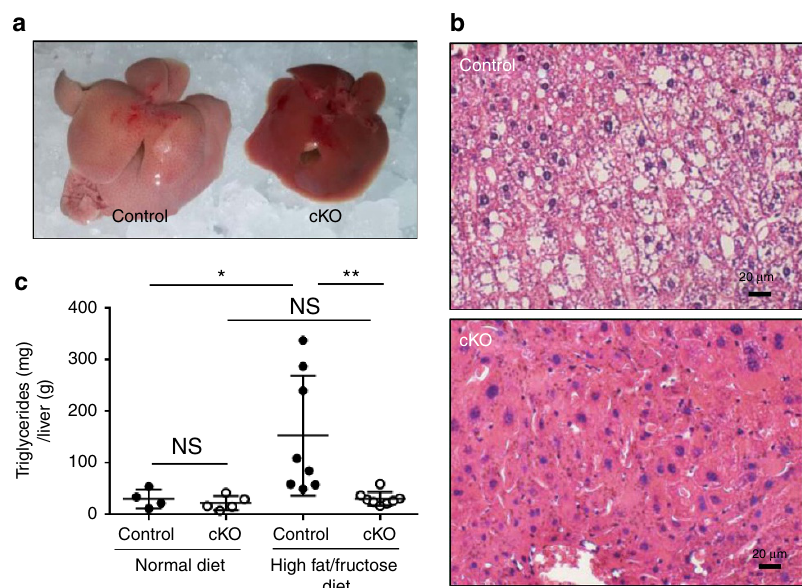
Figure 4 | Ant2 -deletion in the liver prevents fatty liver development under a high fat/fructose diet. Control and Ant2 cKO mice at the age of 6 weeks were subjected to a high fat (40%)/high fructose (20%) diet for 8 weeks. ( a ) Representative images of liver gross appearance ( n ¼ 8). ( b ) Representative images of liver histology analysis with H&E staining ( n ¼ 10). Scale bar; 20 m m. ( c ) Total triglyceride levels in the liver under a normal or high fat/fructose diet ( n 4 5, * P o 0.05, ** P o 0.01 by t -test, error bars ¼ s.d.).